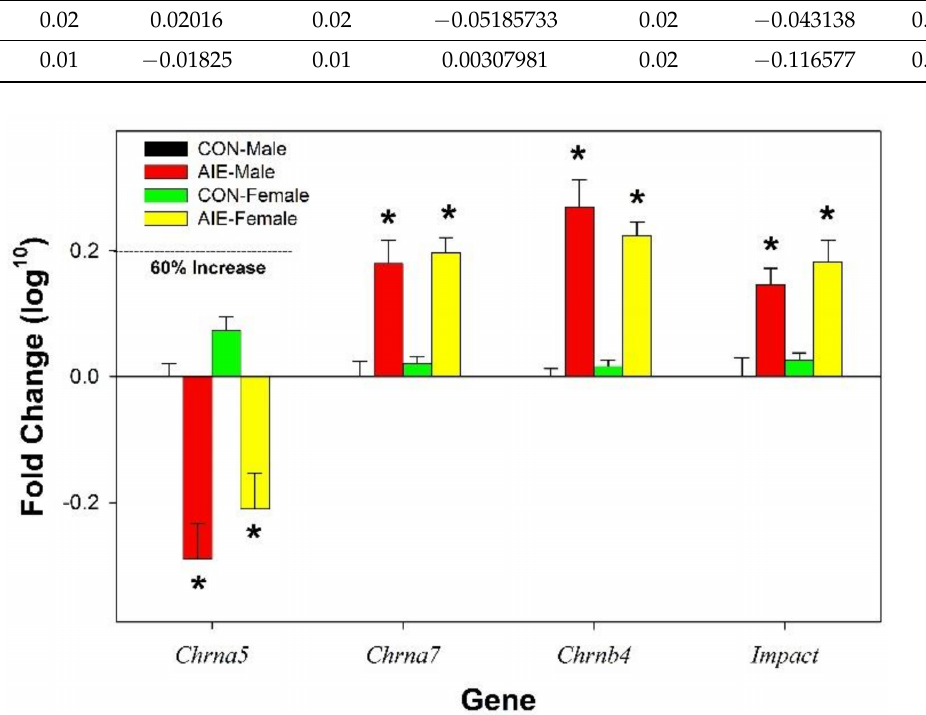
Figure 2. Fold change (log10 normalized to CON males) expression for DA and Ach related genes in the AcbSh in adult CON and AIE male and female Wistar rats. * indicates significantly different from CON-Males and CON-Female values. Data are mean ±